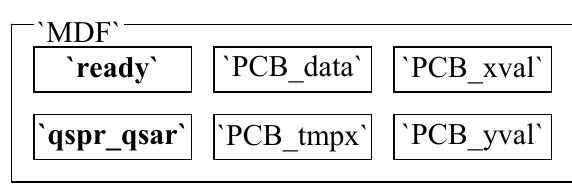
Figure 1. `MDF` database for